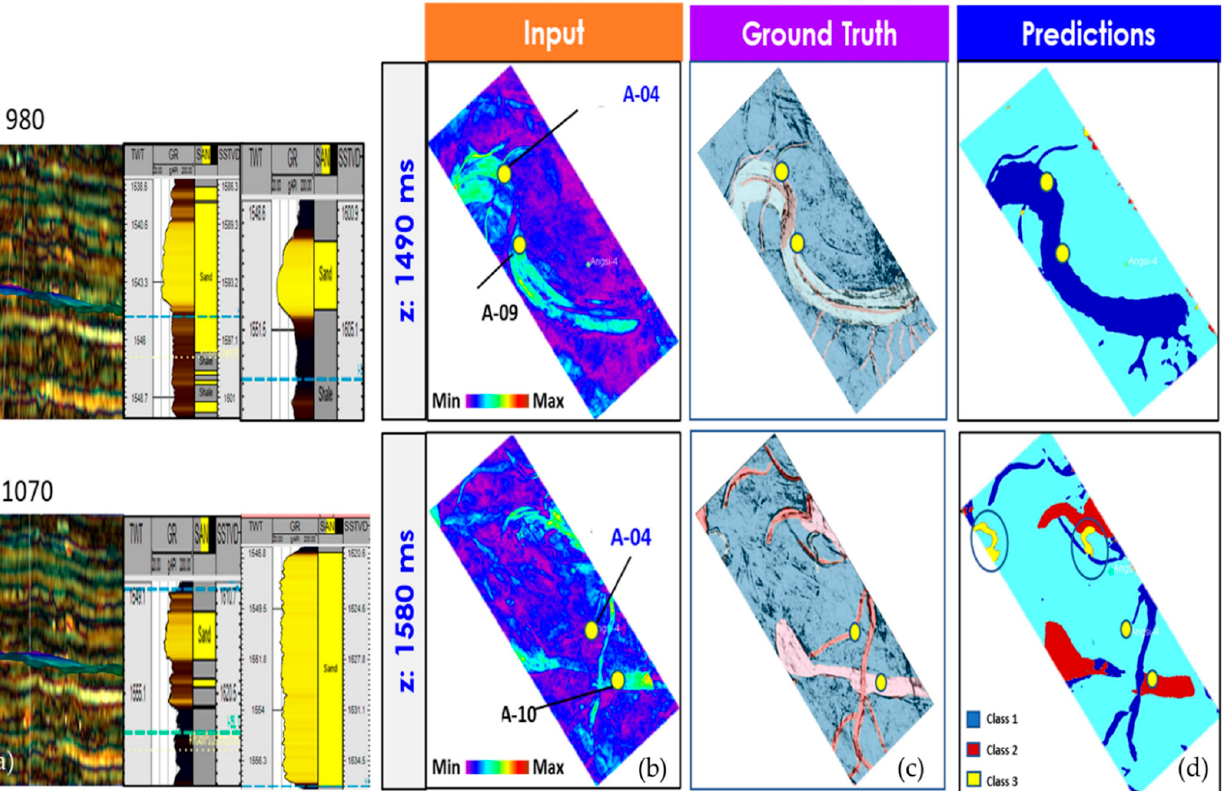
Figure 10. The results for multi- facies classification in A Field. ( a ) Two random sections of blended spectral decomposition cubes passing through three key wells showing log pattern analysis in the channelized reservoir interval. Two different time slices in ( b ) display comparisons between multi- attributes as the input (sweetness attributes shown as the example). ( c ) The labeled data prepared by a human interpreter. Results from multi-facies classification ( d ) show that the trained neural network is capable of capturing Class III facies, as indicated in the ellipse, despite dealing with the challenge of facies imbalance.